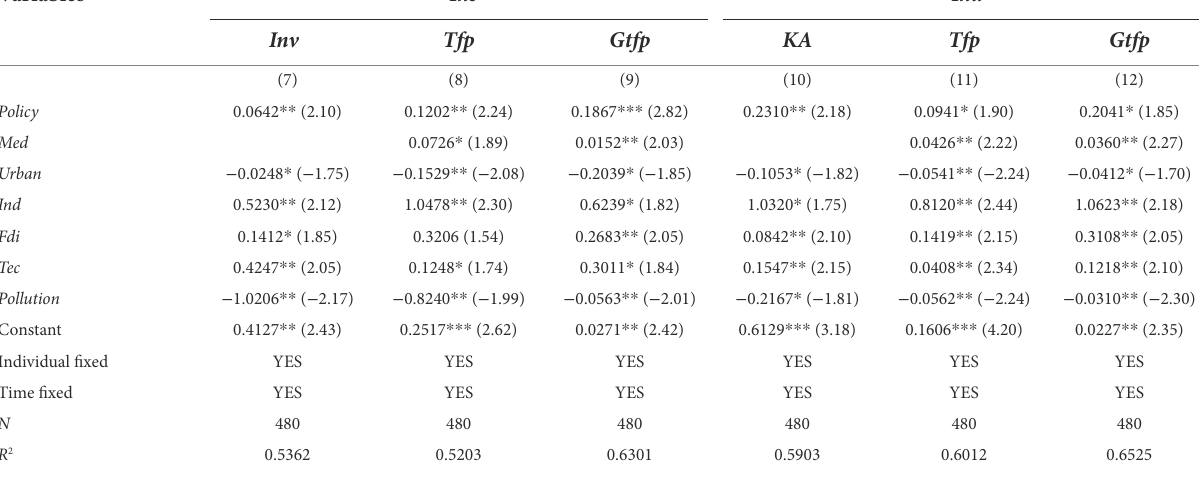
TABLE 7 Results of the impact mechanism test